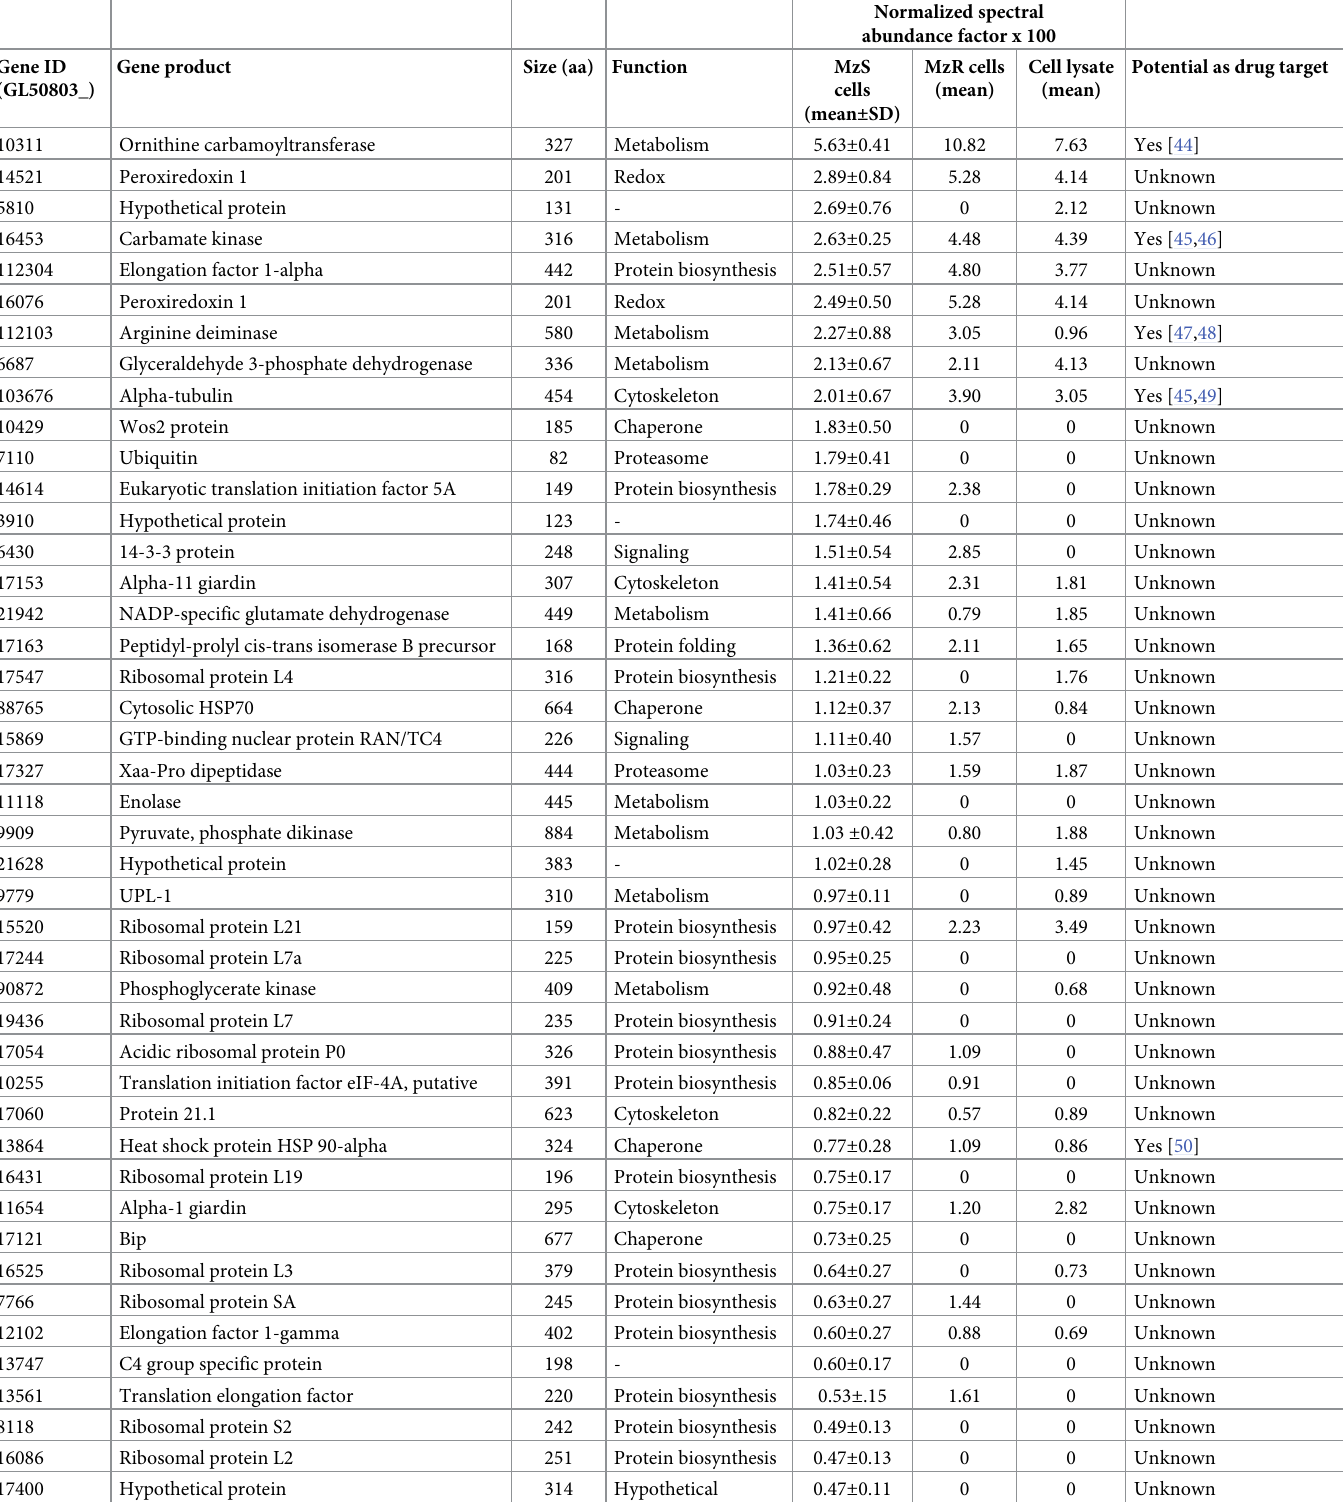
Table 1. Proteins adducted by Mz-alkyne in G . lamblia